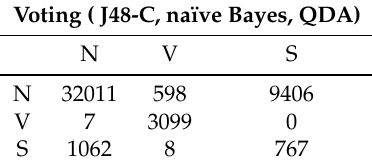
Table 22. Confusion matrix for combining J48-C, naïve Bayes, and QDA classifiers using Voting scheme (N,S,V).